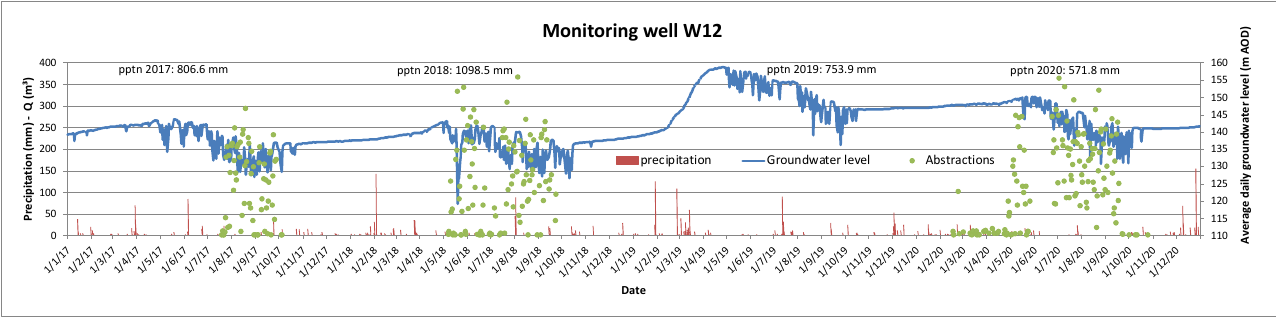
Figure 6. Response of groundwater level to hydrologic conditions and stresses imposed by abstractions. Annual precipitation in the period 2017 to 2020 varied from 22 to 32% between subsequent years and resulted in highly different groundwater recharge heads elevations from 3 to 23 m. In contrast, groundwater heads recession during the irrigation periods are not seen to change significantly from year to year and are sustained at ca 10–12 m. Dynamic heads (groundwater levels during abstraction) drop by 10–15 m depending